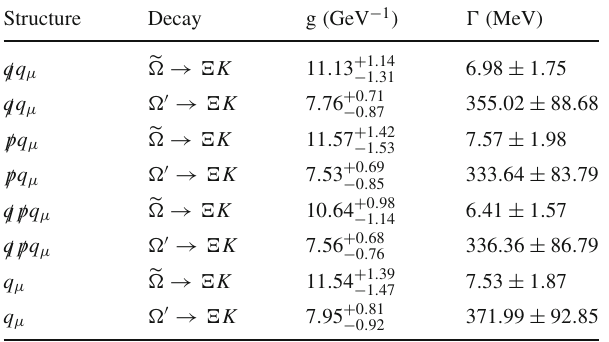
Table3 Totalwidthscorrespondingtotheorbitallyandradiallyexcited (cid:2) states